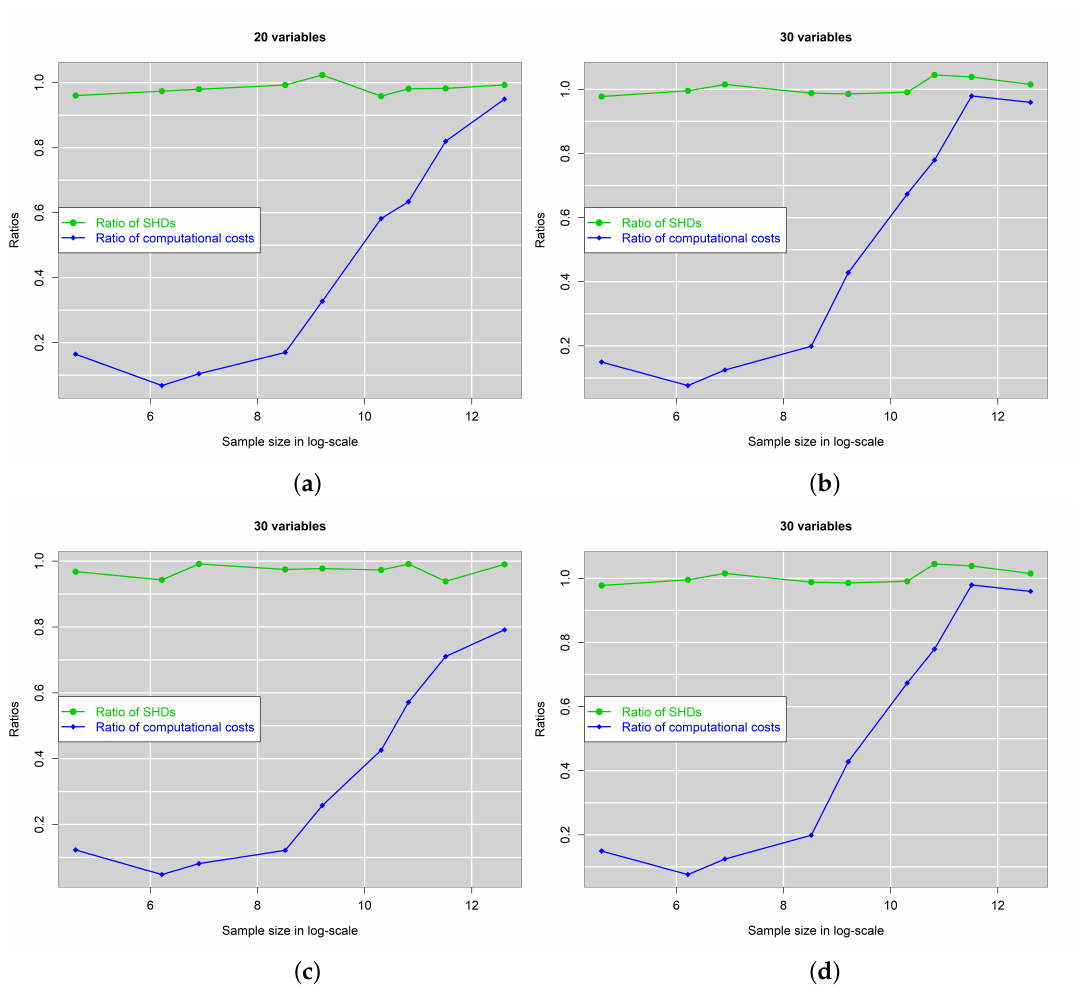
Figure 6. Ratios of SHD and computational cost against log of sample size for various dimensions, with 3 neighbours and 5neighbours on average. The ratios depict the errors and computational cost of the raw FEDHC relative to the robustified FEDHC with NO outliers. ( a , c ) 3 neighbours. ( b , d ) 5 neighbours.